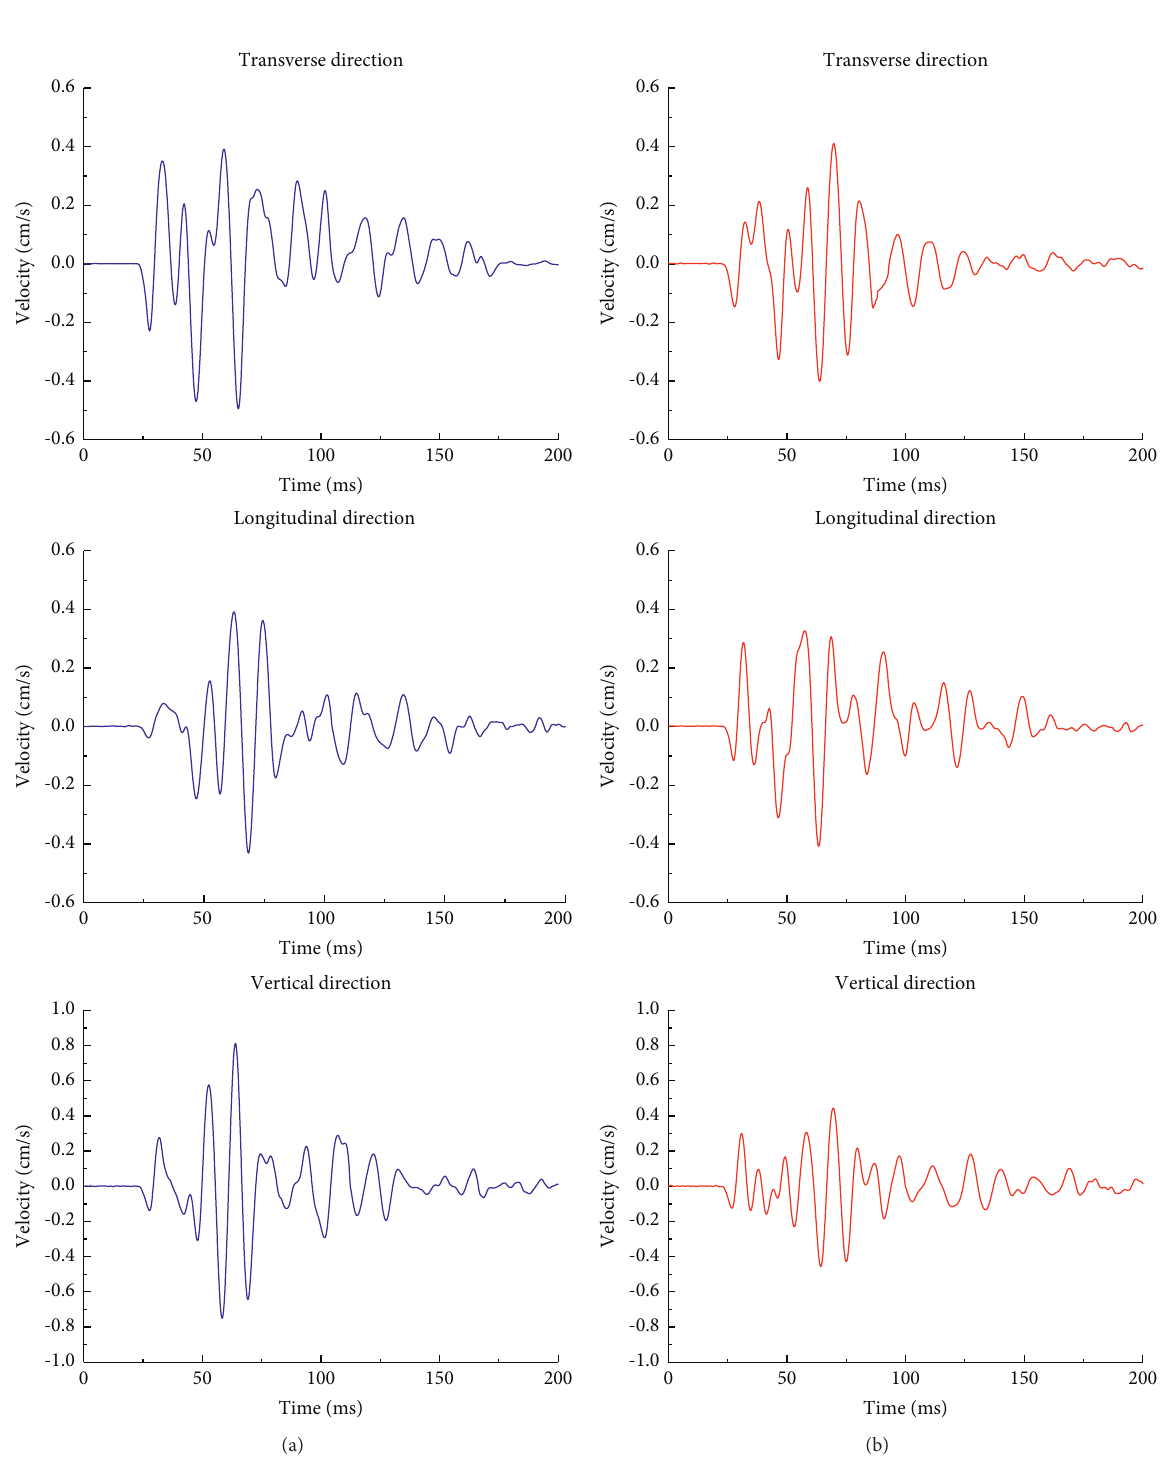
Figure 5: Vibration velocity histories measured at (a) No. 6 monitoring point on the tunnel surface and (b) No. 9 monitoring point on the tunnel entrance slope